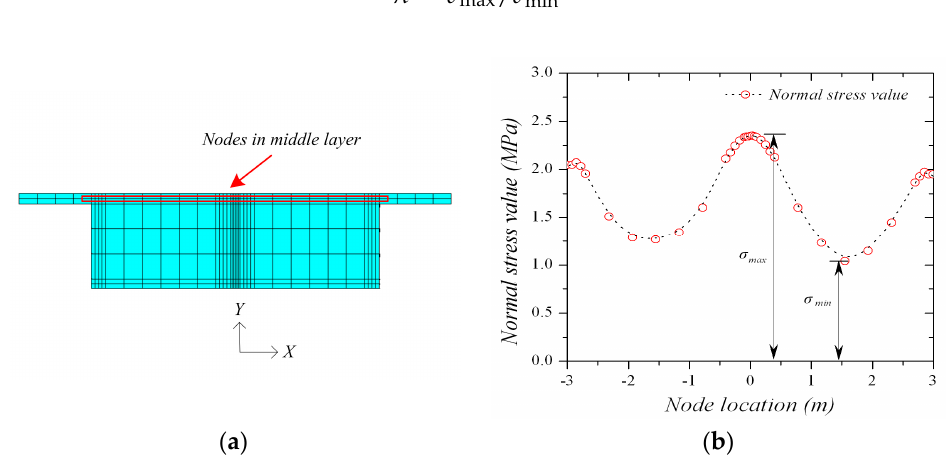
Figure 6. Node selection and normal stress distribution in the top plate of the bifurcation diaphragm. ( a ) Node selected in the top plate; and ( b ) the normal stress distribution of selected nodes.